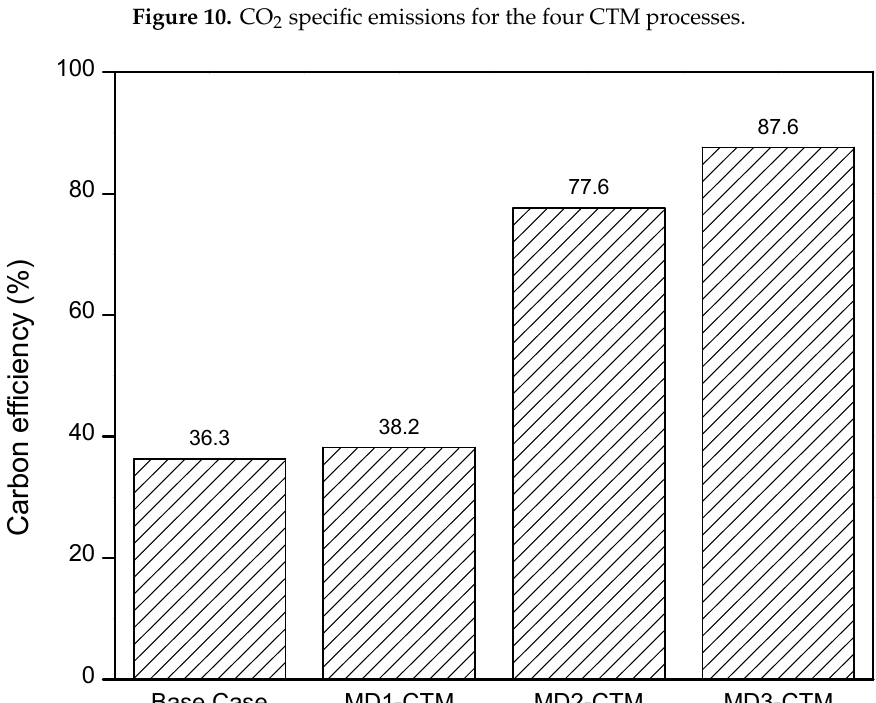
Figure 11. Carbon efficiencies for the four CTM processes.